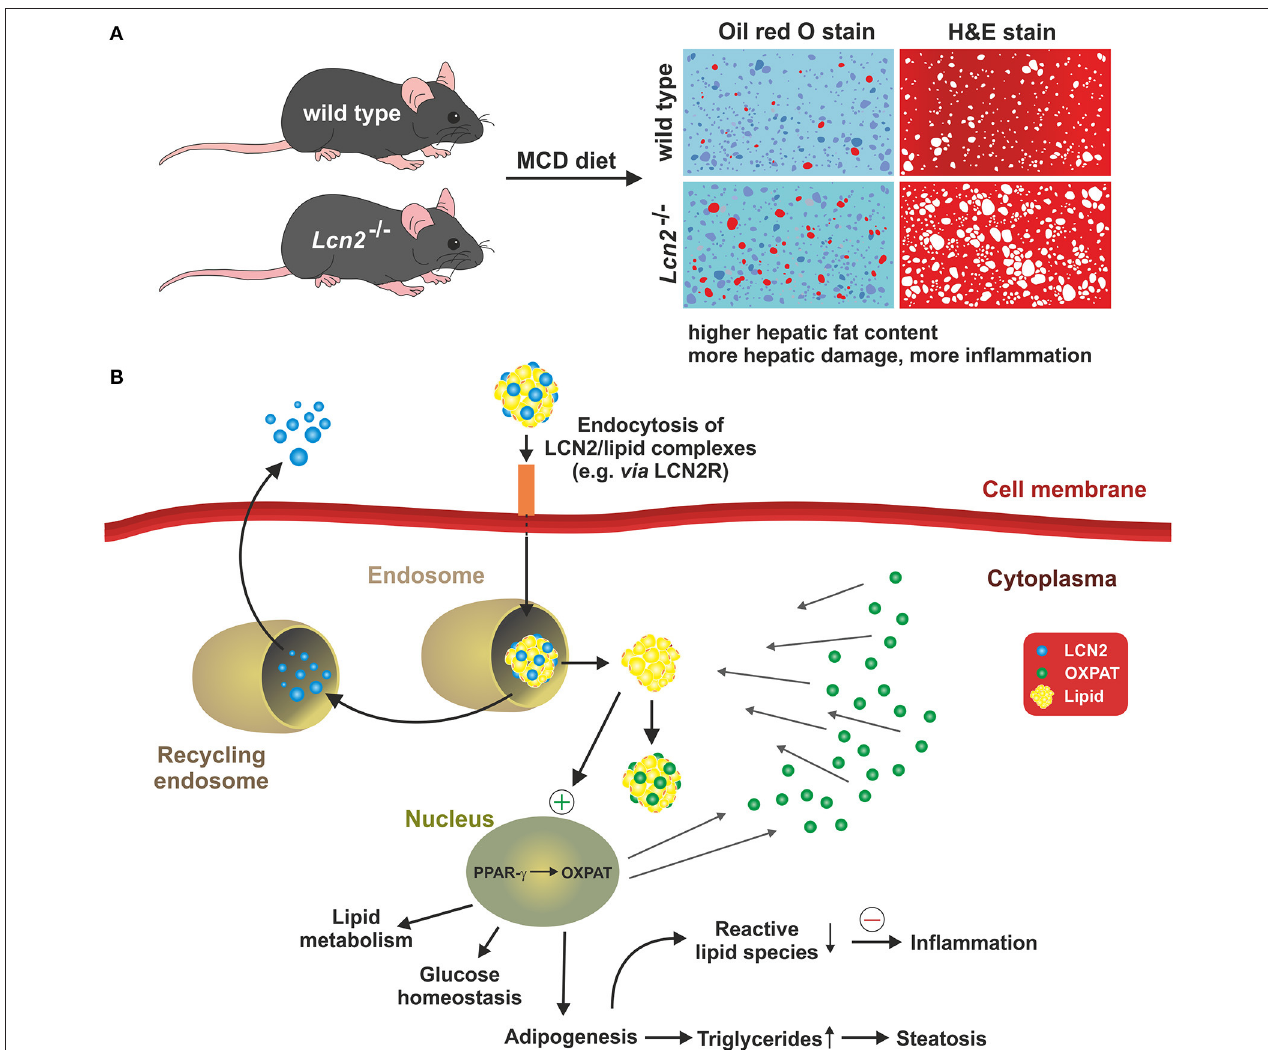
FIGURE 4 | LCN2 and fat metabolism. A recent concept suggests that LCN2 is a key factor in controlling intracellular fat metabolisms in hepatocytes by regulating expression of the lipid droplet protein PLIN5/OXPAT. (A) The concept is majorly based on the finding that mice lacking LCN2 accumulate more lipids in the liver and show more hepatic damage and inflammation when fed a methionine-choline deficient diet (MCD) representing a nutritional model of NASH. (B) In the respective study, it was proposed that LCN2 imports lipids into hepatocytes either via specific receptors (e.g., LCN2R) or unknown endocytosis pathways. Within the cytoplasm, the LCN2/lipid complexes are first packed into endosomes whose slightly acidified microenvironment causes LCN2 to dissociate from the lipids. The lipids then move into the cytoplasm, where they are coated by PLIN5/OXPAT protecting them from intracellular degradation and oxidation. LCN2 may be recycled and secreted. PLIN5/OXPAT itself is up-regulated by PPAR- γ that is stimulated by the higher cytoplasmic fat content that is the consequence of facilitated lipid import by LCN2. Together, the suspected interaction of LCN2, PPAR- γ , and PLIN5/OXPAT presents a complex network that affects lipid metabolism, glucose homeostasis, and adipogenesis. In the presence of LCN2, intracellular concentrations of free reactive lipid species may be reduced and the overall inflammatory responses suppressed. Contrarily, in the absence of LCN2, the concentration of free fatty acids within the cytosol is increased predisposing for inflammation and